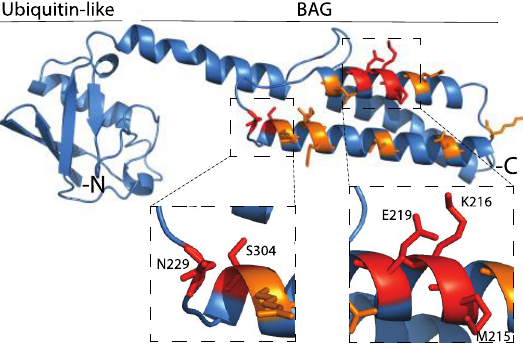
Figure 10. The human BAG-1 protein’s three-dimensional structure shows the amino acids’ position interacting with Hsp70 (orange) and the position of the naturally occurring mutations.